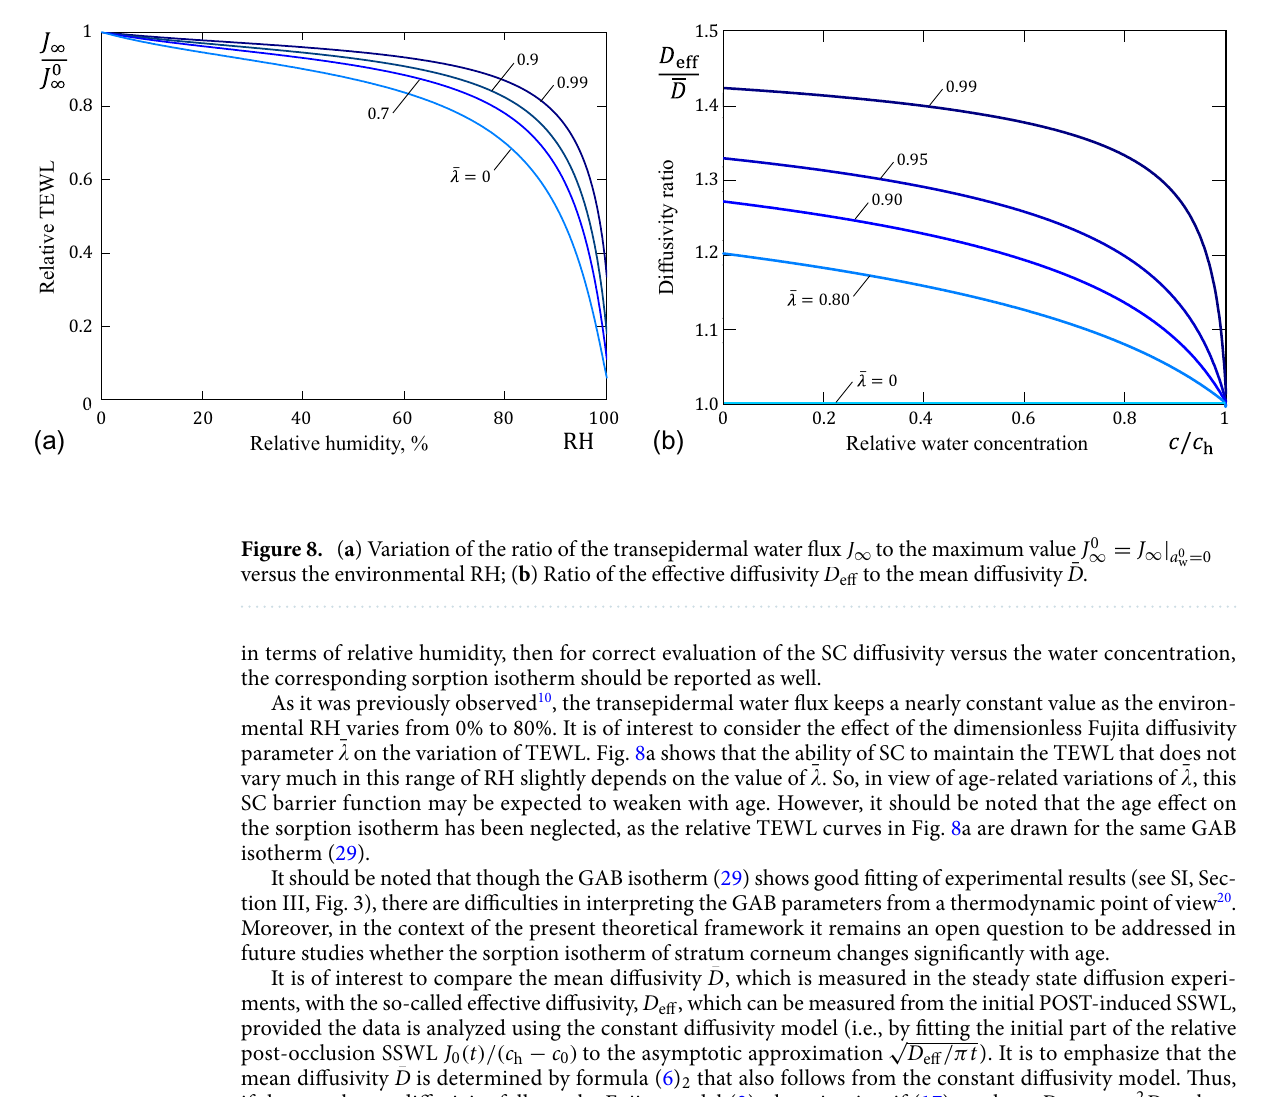
Figure 8. ( a ) Variation of the ratio of the transepidermal water flux J versus the environmental RH; ( b ) Ratio of the effective diffusivity D eff to the mean diffusivity ¯ D